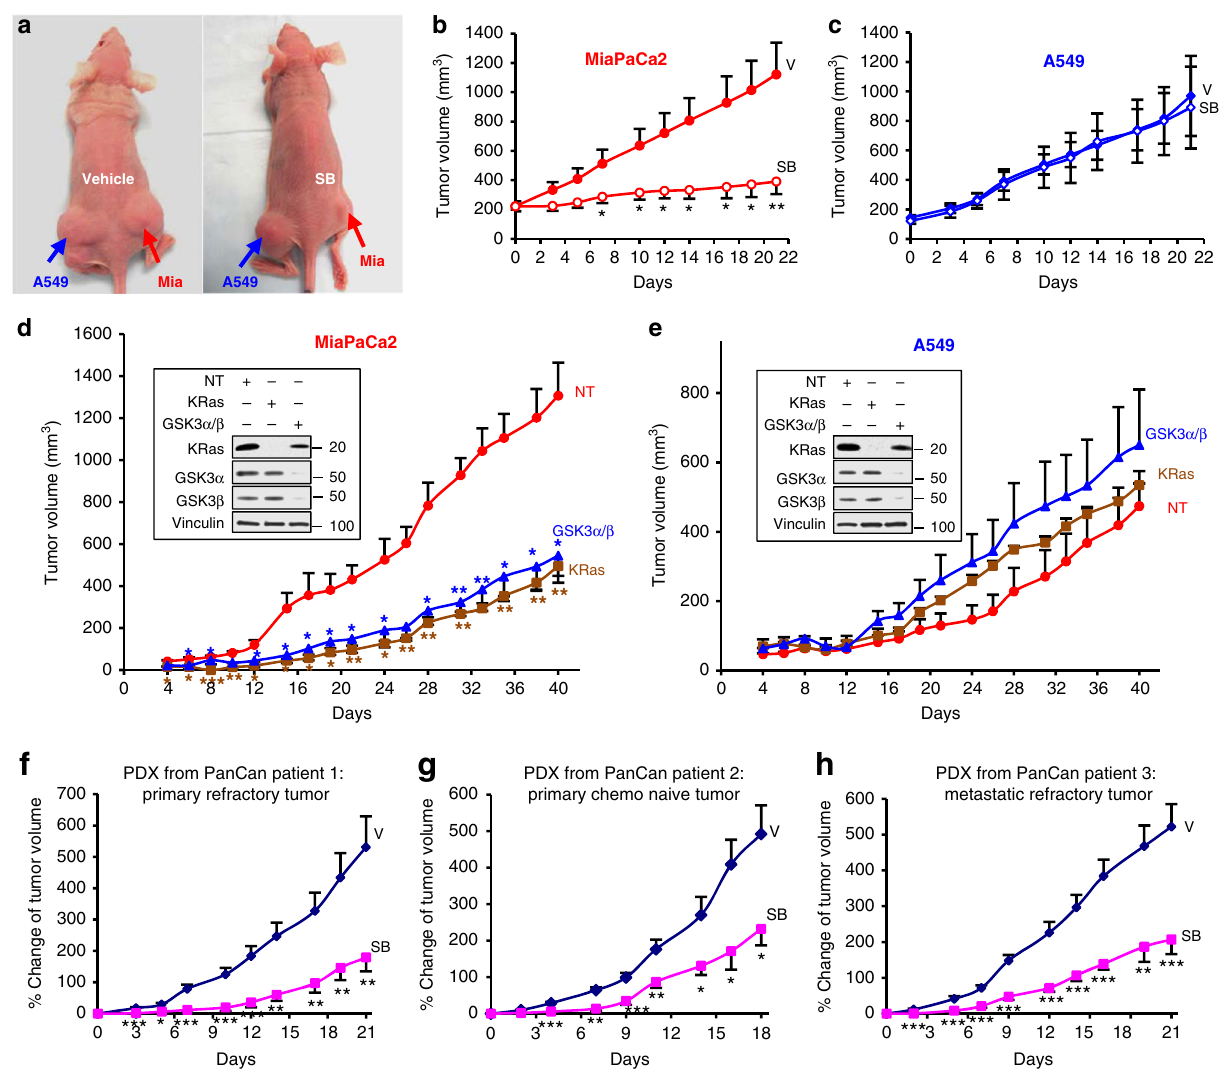
Fig. 3 SB suppresses mutant KRas-dependent tumors and pancreatic cancer patient xenografts. MiaPaCa2 and A549 cells were implanted on the right and left fl ank, respectively, and mice were treated daily with vehicle (V) or SB (50 mg/kg). a Representative mice treated with either V or SB. b , c Effects of SB on the average tumor growth of all mice (V; 5 mice and SB; 6 mice). Experiment was repeated three times. d , e Average tumor volume of MiaPaCa2 and A549 tumors transfected with NT siRNA, KRas siRNA, or GSK3 α / β siRNA (NT; 3 mice, KRas sRNA; 3 mice, and GSK3 siRNA; 3 mice). Experiment done once. For b and c , day 0 corresponds to day 14 after tumor implantation when the average tumor volumes were 150 – 200 mm 3 ; for d and e , day 0 corresponds to the day when the tumors were implanted. Insets: western blots con fi rming depletion of KRas and GSK3. f – h Effects of vehicle and SB on the growth of patient-derived xenografts (PDXs) of chemotherapy/radiation-resistant primary ( f ), chemo-naive primary ( g ), and chemo/radiation-resistant metastatic ( h ) tumors from pancreatic cancer patients. For f and h , V; 10 mice and SB; 10 mice. For g , V; 10 mice and SB; 9 mice) (* P < 0.05; ** P < 0.01; *** P < 0.001). P values determined by Student ’ s t